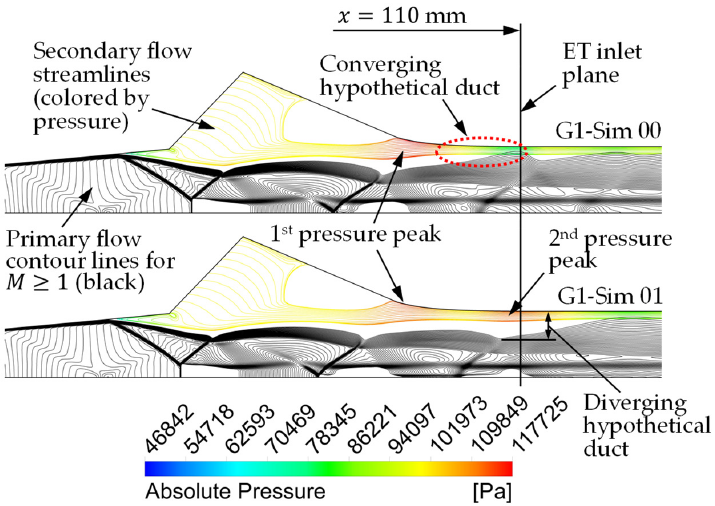
Figure 16. Streamlines plot (colored by pressure) started from the secondary flow inlet for ejector G1 with operating conditions of sim 00 ( P 0 = 618 kPa; top), and 01 ( P 0 = 584 kPa; bottom). Mach number contour lines of the primary flow for M ≥ 1 (black lines) are superimposed onto it to see the shock cells position and size.